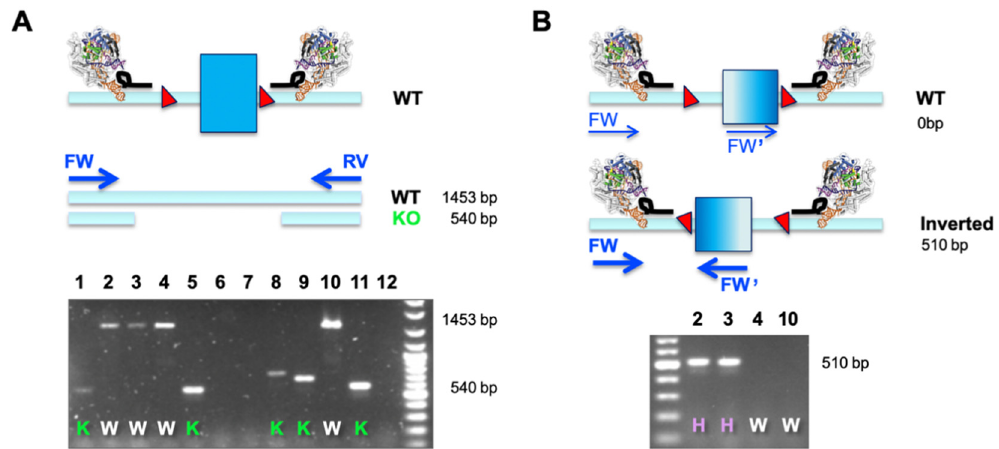
Figure 2. Typical PCR screening outcomes when performing a dual sgRNA-mediated deletion. Gel images are based on representative data from the R3 deletion generated in mouse E14 ESCs (Hba R3), as described in Table 1. ( A ) After isolation of clonal lines, gDNA is isolated and PCR primers flanking the critical exon are used to amplify either WT or deletion fragments. Presence of the shorter fragment is indicative of deletions, and this approach is irrespective of cellular ploidy. The agarose gel gives a representative result of 12 independently screened clones, with 5 full KOs (K; lines 1, 5, 8, 9 and 11) and 4 unedited clones (W; lines 2, 3, 4 and 10). Three clones did not yield any band, possibly due to low-quality gDNA. ( B ) We observe an unexpectedly high number of clones with excisions and inverted re-insertions that would appear as WT if uncontested (see also Table 1). Such events do qualify as bona fide null alleles due to the co-inverted splicing signatures and consequent exon skipping. We generally apply a secondary PCR screen using two FW oligos (FW and FW’ as indicated in the schematics) where only re-inserted inversion of the excised fragment will generate an amplicon. As such, from clones 2, 3, 4 and 10 (previously classified as WT as shown in Figure 2A), clones 2 and 3 turned out to be at least heterozygously deleted, indicated by “H”. For more than diploid lines, a third PCR will be required to determine the full allelic spectrum (e.g., FW inside and RV inside; data not shown). This is especially important if bona fide CRISPR / Cas9 treated WT clones are required for appropriate controls, or if low numbers of full KO clones are obtained and heterozygous clones can be re-screened as detailed and potentially more full KO clones can be